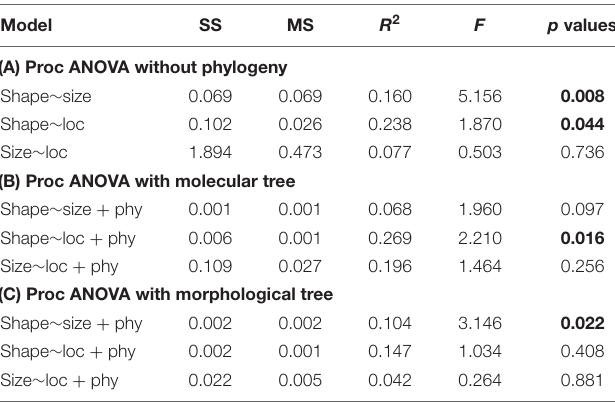
TABLE 2 | Xenarthra summary statistics for different Procrustes ANOVA models without (A) and with (B, C) accounting for the phylogenetic effect. Model SS MS R 2